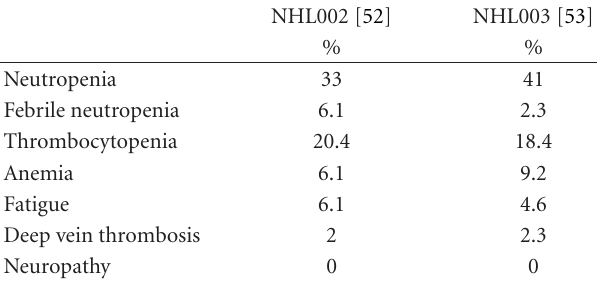
Table 2: Grade III-IV toxicities with lenalidomide as monotherapy in relapsed/refractory